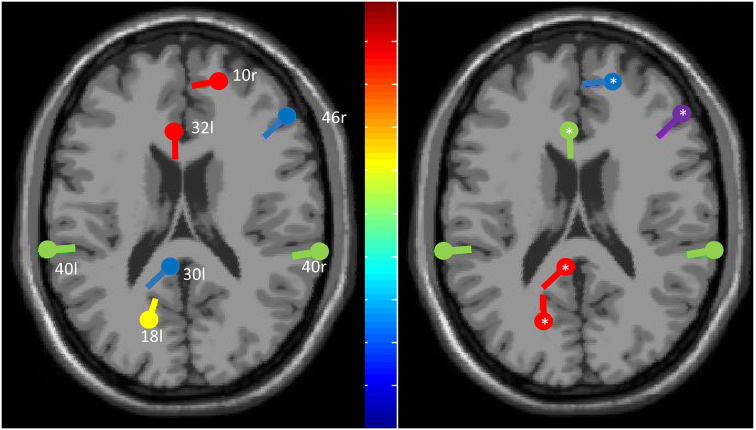
The plot of the equivalent dipoles (center) for the maximally independent brain source components (IC), i.e., those with a residual variance below 30% before and after Repetitive transcranial magnetic stimulation (rTMS) treatment (*means a statistically significant change, p < 0.001) across the 19-channel component scalp map based on fitting the measured 2D electrode locations to an individualized three-shell boundary element method head model. IC is color-ranked in order of variance contributed to the scalp data (colors show significant deviations in log power (dB) from baseline; green indicates no changes). Given that all the residual variances were low, the component maps are compatible with an origin in a single cortical patch.